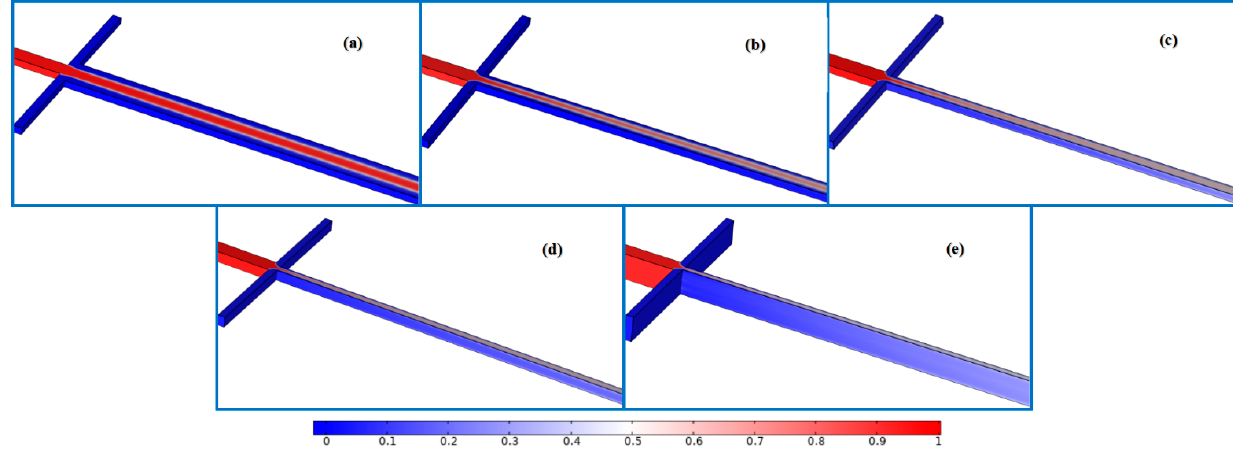
Figure 10. The distributions of concentration under different aspect ratios: ( a ) H/W = 0.2, ( b ) H/W = 0.5, ( c ) H/W = 1, ( d ) H/W = 2, ( e ) H/W = 5.